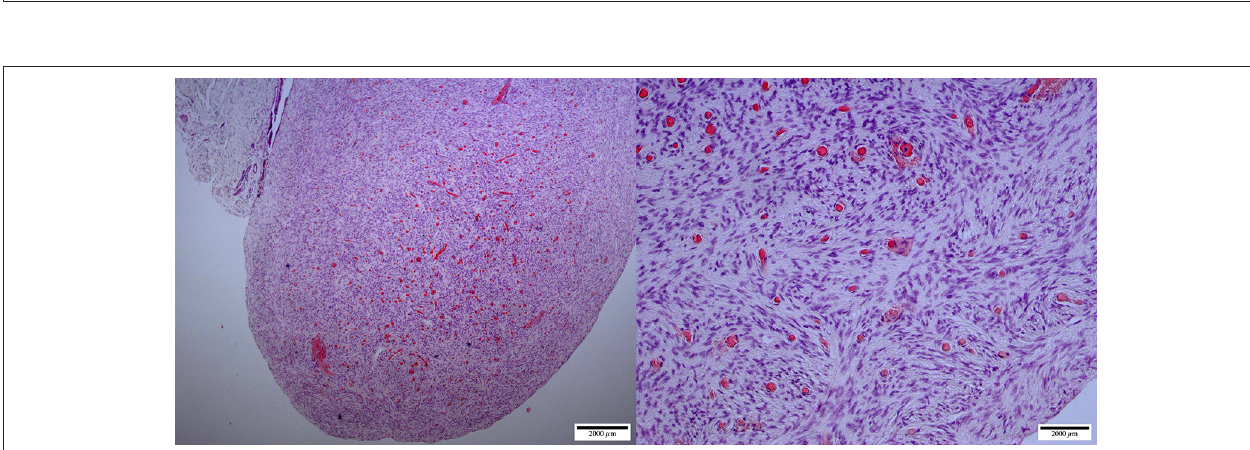
FIGURE 5 | Reproductive tract from a female with ovarian hypoplasia/dysgenesis. (A) Entire tract showing the tubular genitalia with the small flaccid uterus. (B) Ovary measuring 3mm in length by 2mm in width (arrows).